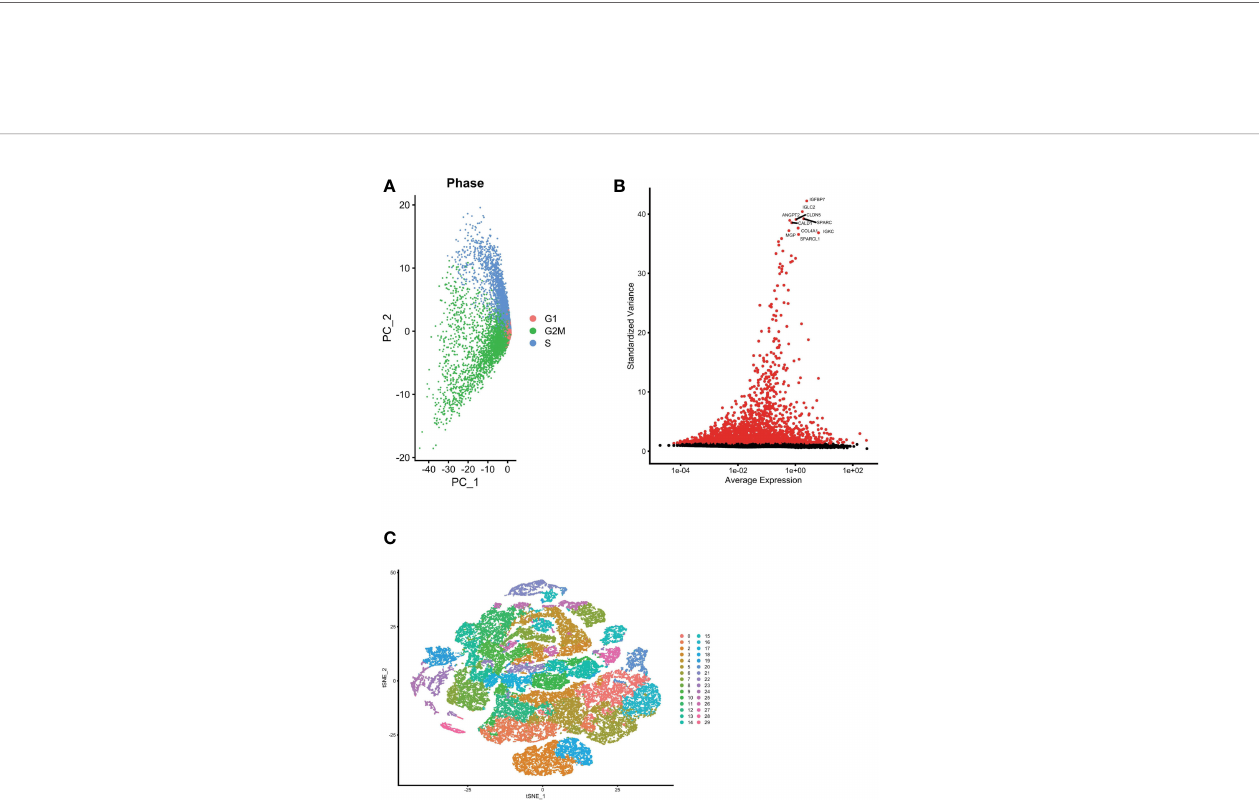
FIGURE 6 | Analysis of immune checkpoint(ICP) and microsatellite instability(MSI). (A) The expression level of immune checkpoint related genes was higher in the high-risk group. (B) Microsatellite instability was lower in the high-risk group. (C) Correlation analysis also showed that microsatellite instability decreased as the risk score increased. (**P < 0.01, ***P < 0.001).